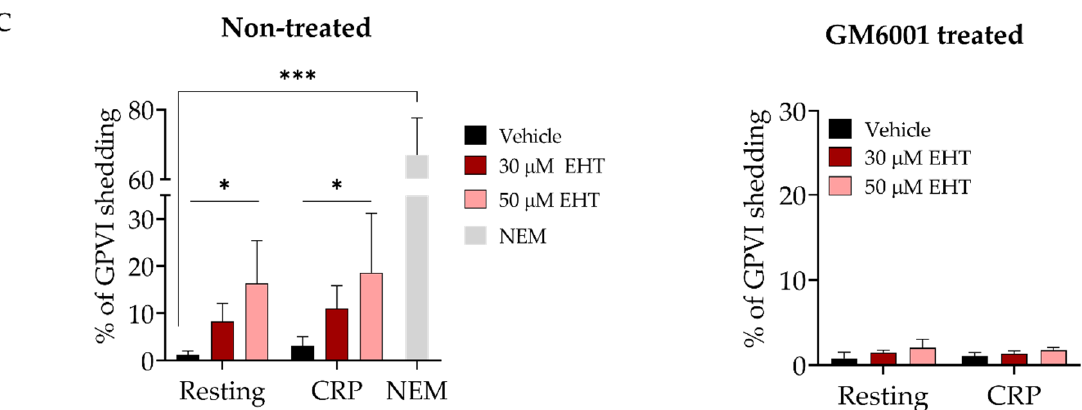
Figure 2. The effect of EHT1864 on GPVI-induced platelet activation and GPVI shedding. ( A ) Dose- dependent reduction in platelet activation and GP exposure by EHT1864. ( Ai ) Flow cytometric analysis of resting or CRP-activated (5 µ g/mL) human platelet activation, pre-treated with vehicle (PBS) or EHT1864 (30 or 50 µ M) for 10 min at 37 ◦ C, and labelled with Alexa Fluor ® 647 conjugated anti-human activated CD41/CD61 (PAC-1) antibody, ( Aii ) FITC-labelled anti-P-selectin antibody, ( Aiii ) PE-conjugated anti-human GPVI (HY101) antibody, and FITC or APC-conjugated anti-human antibodies for ( Aiv ) GPV, ( Av ) GPIb α , ( Avi ) integrin β 3-subunit and ( Avii ) CLEC-2 ( n = 3). ( B ) GPVI shedding induced by EHT1864. Representative Western blots showing GPVI shedding on non- treated and GM6001 (250 µ M, broad matrix metalloproteinase inhibitor) treated human platelets, non-stimulated or stimulated with CRP (5 µ g/mL) and pre-incubated with vehicle (PBS) or EHT1864 (30 or 50 µ M) or stimulated with NEM (2 mM). ( C ) Quantification of the percentage GPVI shedding induced by EHT1864 on non-treated or GM6001 (250 µ M) treated human platelets ( n = 3). Mean ± SD * p < 0.05, ** p < 0.01, *** p < 0.001 by two-way ANOVA (comparing vehicle vs EHT1864